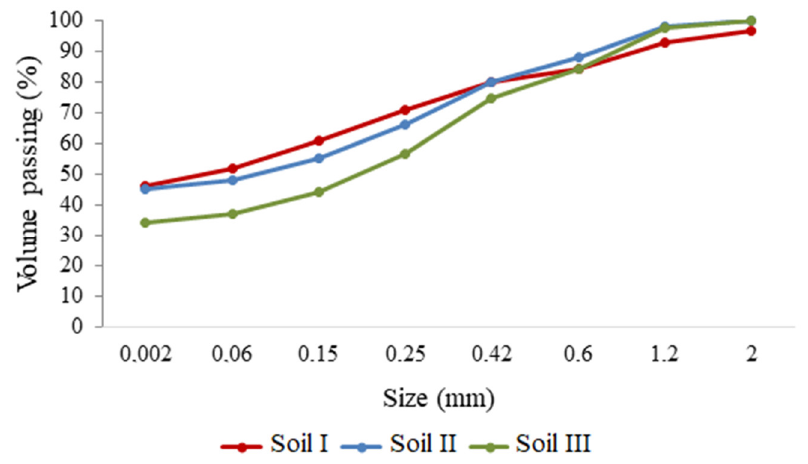
Figure 6. Particle size analysis of soil samples.